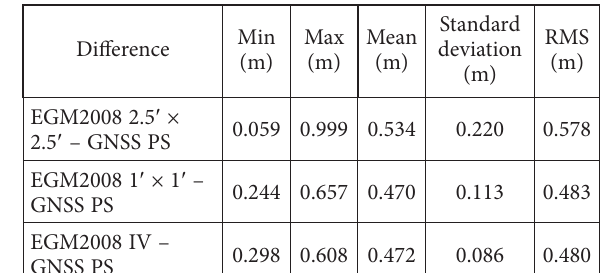
Table 2. Statistics of the differences between EGM2008 (2.5 ′ ×